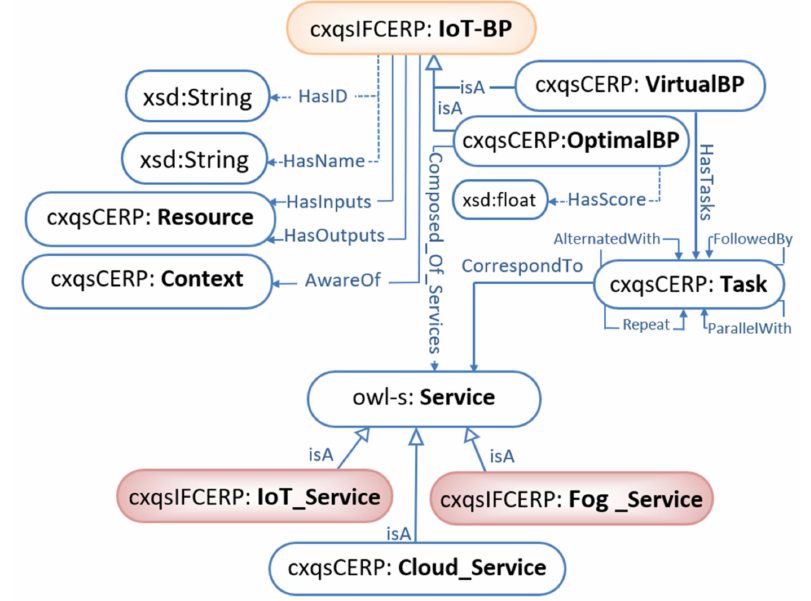
Figure 7. A semantic model of context-aware IoT business